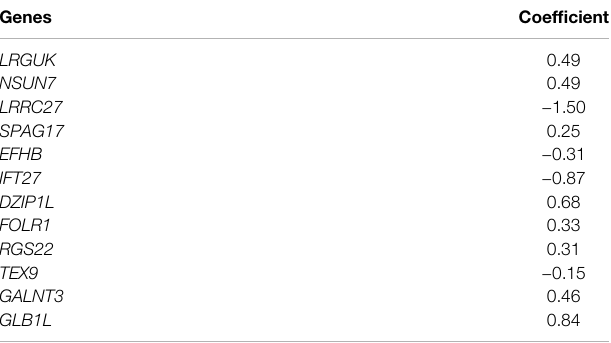
TABLE 1 | Coef fi cients for calculation of cilium risk score. Genes Coef fi